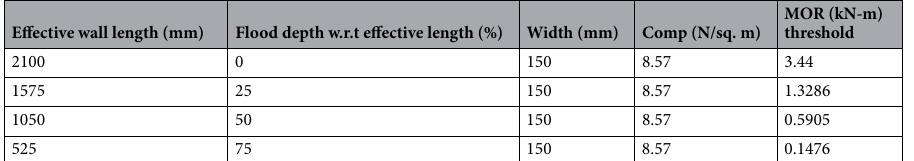
Effective wall length (mm)